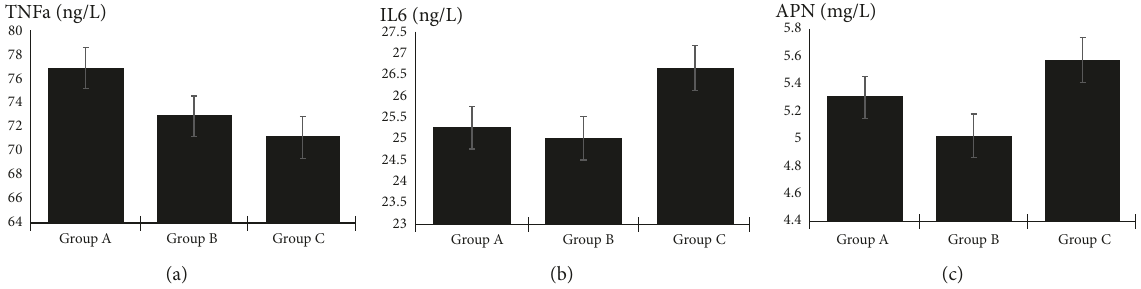
Figure 3: (a) Comparison of TNF- 𝛼 concentration among three subgroups. (b) Comparison of IL-6 concentration among three subgroups. (c) Comparison of APN concentration among three